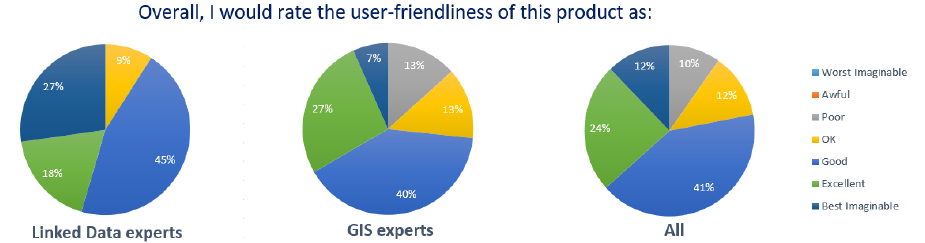
Adjective ratings per user category: Linked data experts ( left ), GIS experts ( center ), all ( right